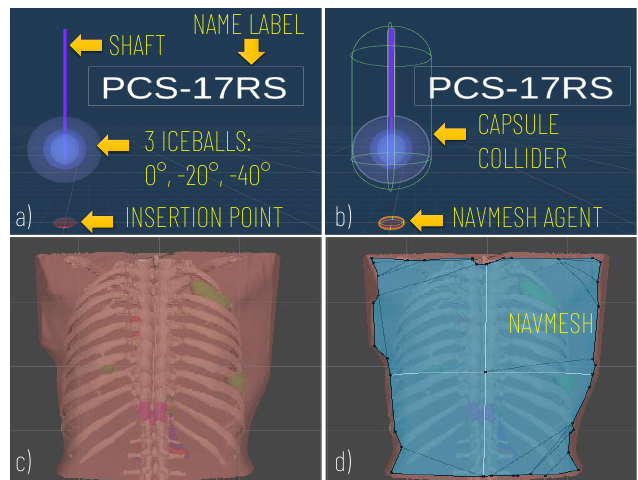
Figure 2. Modelling of the Cryoprobe and the anatomy. ( a ) A cryoprobe prefab comprising the model of the needle, three isotherm ice balls, the insertion point, and a label for the model’s name; ( b ) Unity components added to the cryoprobe prefabs: capsule collider to allow the cryoprobe selection via mouse click; ( c ) Example of the anatomical model imported; ( d ) The navigation mesh (in blue) baked on the torso of the patient and used to implement the interactive navigation of the insertion point on the skin).